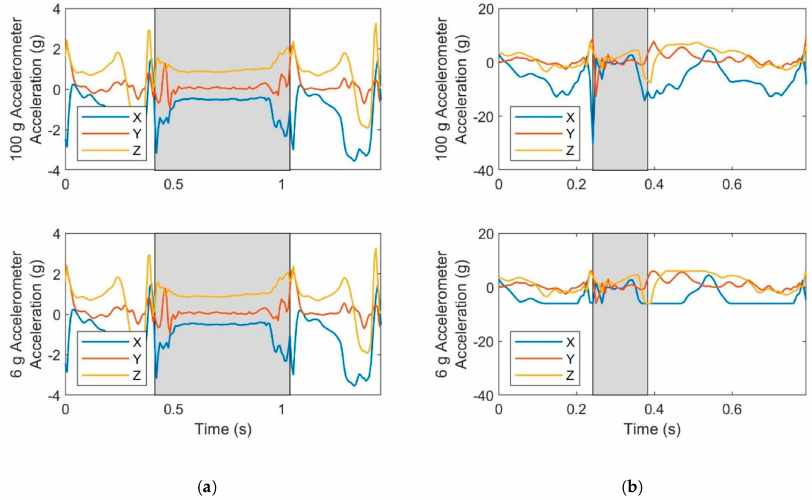
Figure 4. E ff ect of accelerometer range limits on acceleration data for a sample ( a ) walking trial (mean speed 1.4 m / s) and a sample ( b ) running trial (mean speed 5.8 m / s). Acceleration data is saturated when the slope is zero as is most apparent for the X -axis acceleration of the 6 g accelerometer for the running trial. Shaded areas indicate stance